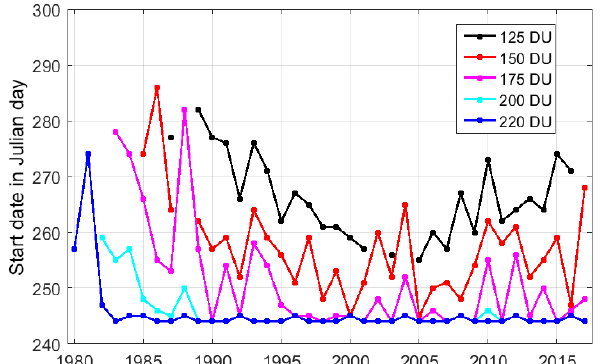
Figure 13. Start day of occurrences of total ozone levels lower than different thresholds (125, 150, 175, 200 and 220DU) computed from the MSR-2 dataset using the 400–600K classification between 1 September and 15